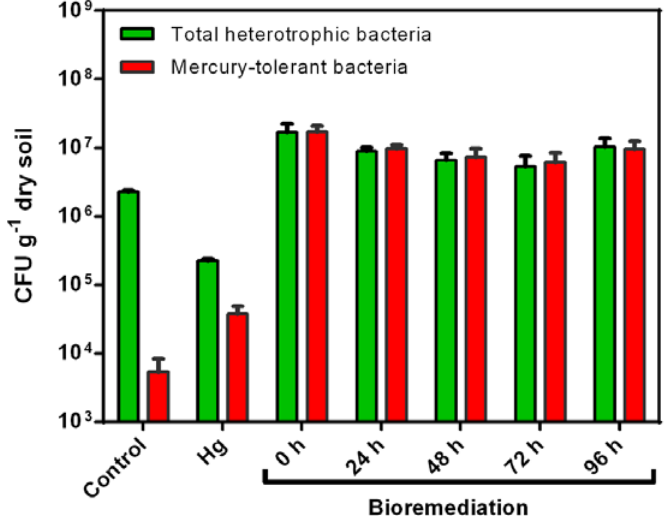
Figure 4. Effect of mercury and mercury bioremediation on the number of total heterotrophic and mercury-tolerant bacteria in agricultural soils. Total heterotrophic and mercury-tolerant bacteria were evaluated on TSA medium and TSA medium-plus mercury (10 ppm), respectively. Control: non- polluted agricultural soil; Hg: agricultural soil exposed to mercury (II) (20 ppm); Bioremediation: mercury-polluted agricultural soil bioremediated on rotary drum bioreactor by C. metallidurans strain MSR33 at different times. Green bars indicate total heterotrophic bacteria and red bars indicate mercury-tolerant bacteria. The bacterial count was performed in quintuplicate. Bars indicate the standard deviation.